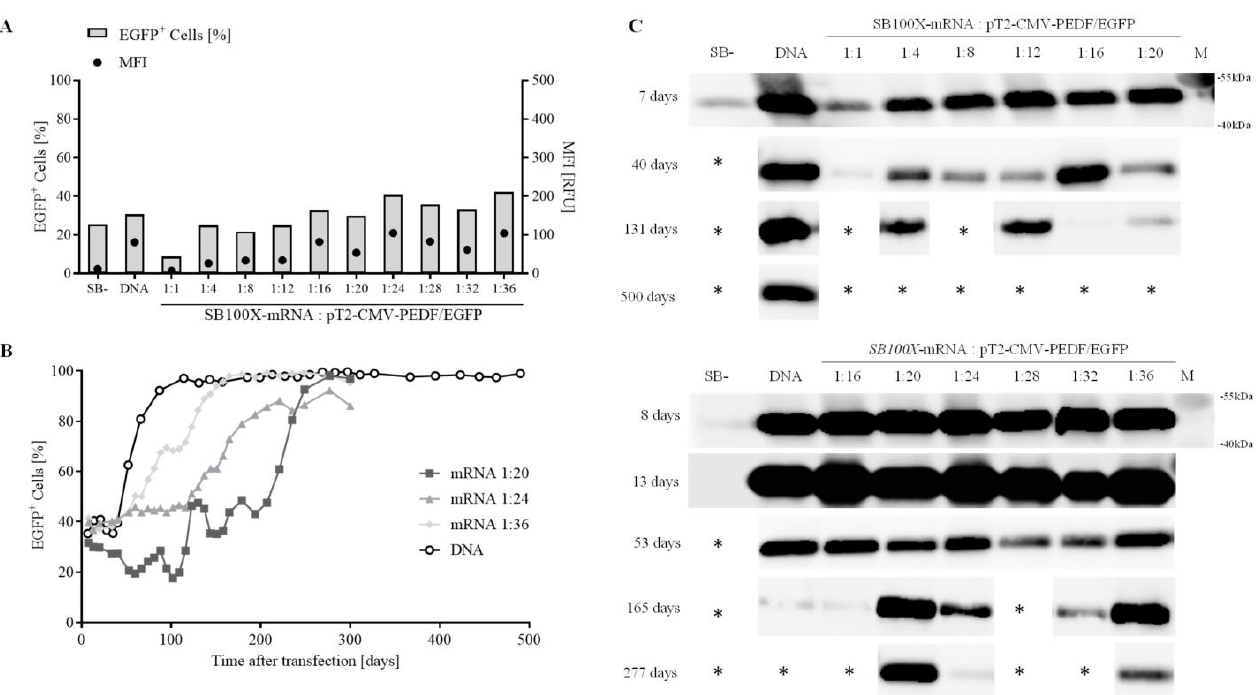
Figure 4. Analysis of transfection efficiency and long-term expression in ARPE-19 cells transfected with pT2-CMV-PEDF/EGFP. ARPE-19 cells were transfected with pT2-CMV-PEDF/EGFP and SB100X-mRNA at ratios from 1:1 to 1:36 with a total amount of 500 ng nucleic acid. SB100X-DNA served as the positive control, the inactive transposase pSB- as negative control, both at a ratio of 1:28. Cultures were observed regularly and were terminated when no rPEDF signal was detected by Western blot. ( A ) Initial transfection efficiency was determined 1 week after transfection by flow cytometric analysis, measuring the percentage of EGFP-positive cells (bars, left axis) and the MFI (dots, right axis). ( B ) Three cultures (ratio of 1:20, 1:24, and 1:36) were monitored over a period of 277 days and the SB100X-DNA control culture for 500 days. ( C ) Western blot analysis was carried out on His-tag purified proteins from culture media of transfected cells using penta-his tag antibodies at different time points for 2 experimental series (top and bottom). Cultures were terminated when only a low or no rPEDF secretion was detectable by Western Blot or when the percentage of fluorescent cells decreased below 10%. Terminated cultures are labeled with *. Please note that not all performed Western Blots are shown here. All Western Blots can be found in the Supplementary Materials (Figures S2 and S3) together with the fluorescence analysis of all samples for the entire duration of the experiments.